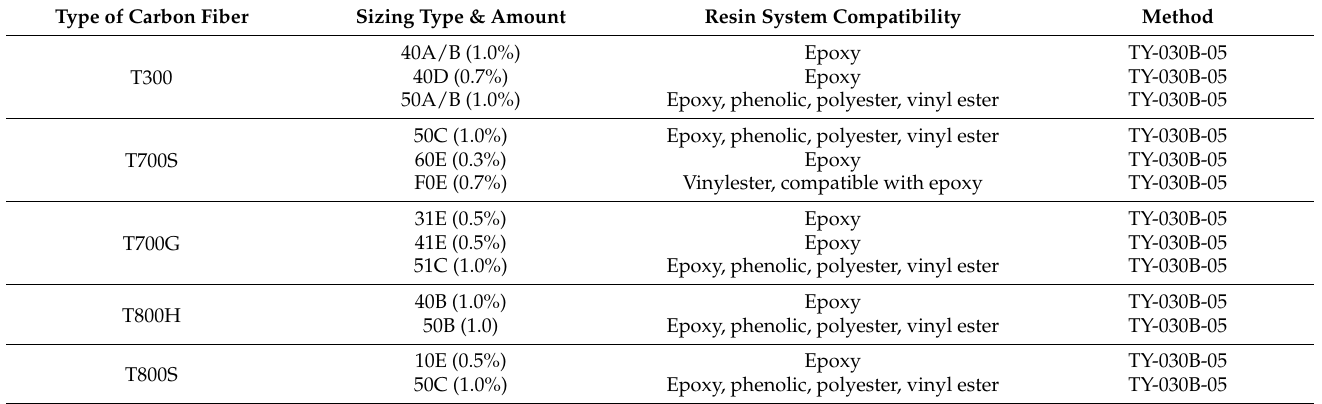
Table 2. Type of carbon